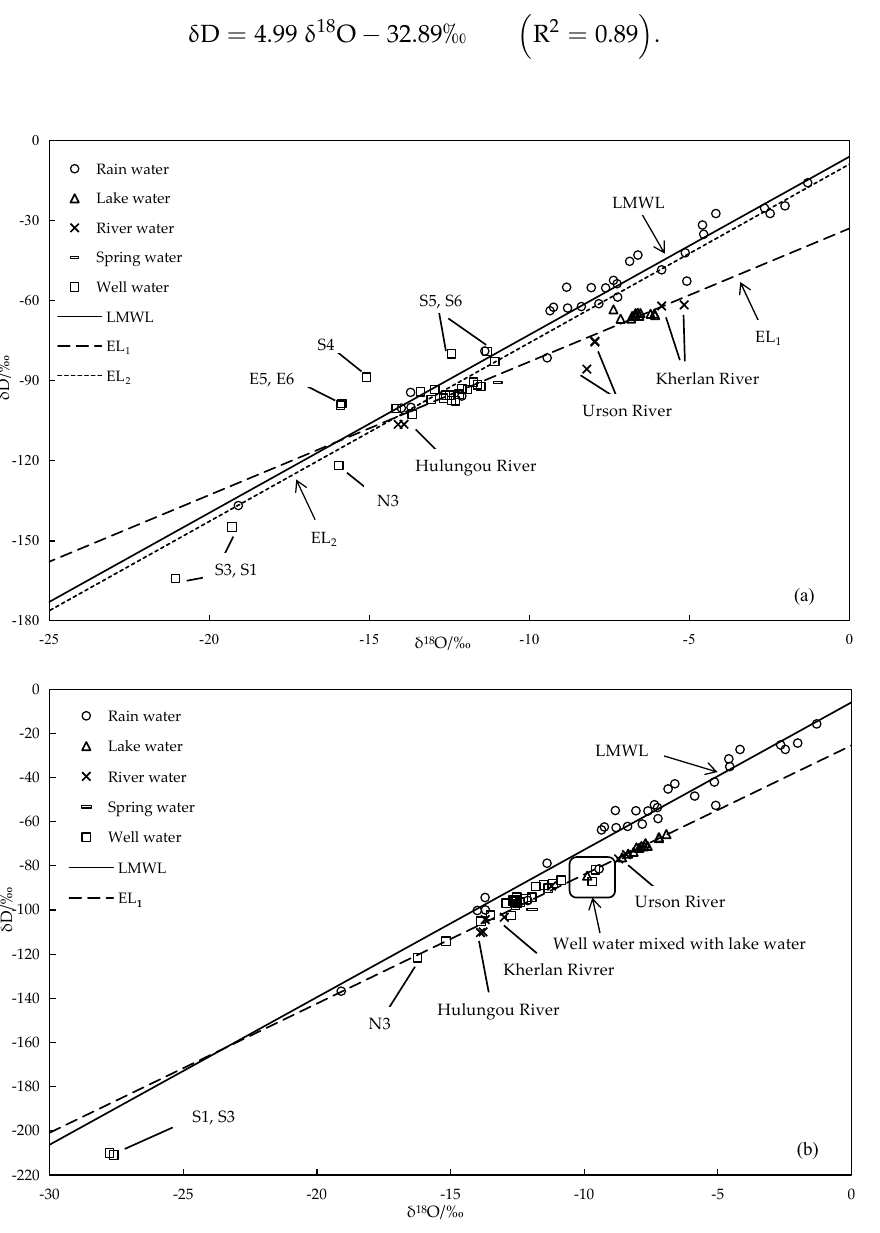
Figure 4. Relationship between the levels of hydrogen and oxygen isotopes in lake, river, groundwater and precipitation in the Lake Hulun area during non-frozen ( a ) and frozen ( b ) periods. EL 1 : the evaporation trend line for the Lake Hulun area. EL 2 : the evaporation trend line of the